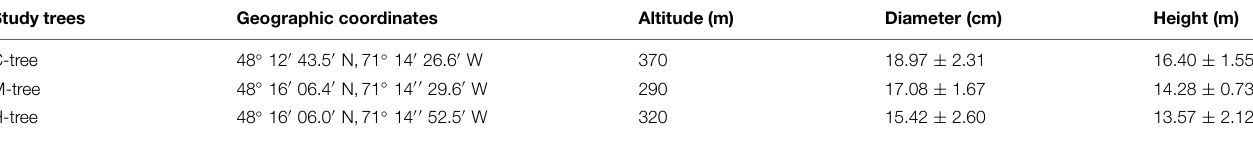
TABLE 1 | Diameter (DBH 1.3 m) and average height of the six sampled trees in each study sites. Study trees Geographic